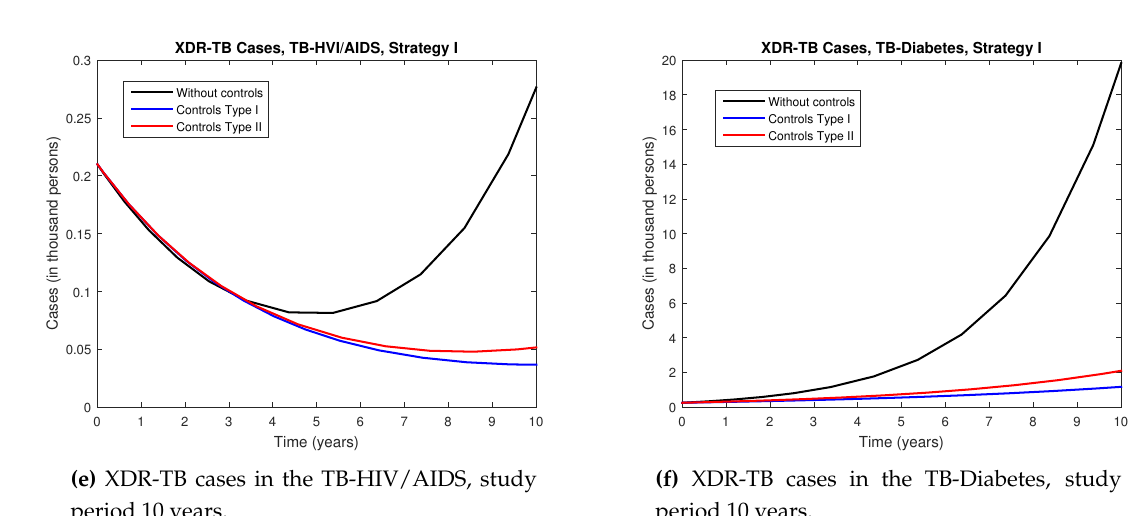
Figure 3. Comparison in the resistance compartments between the types of controls for strategy